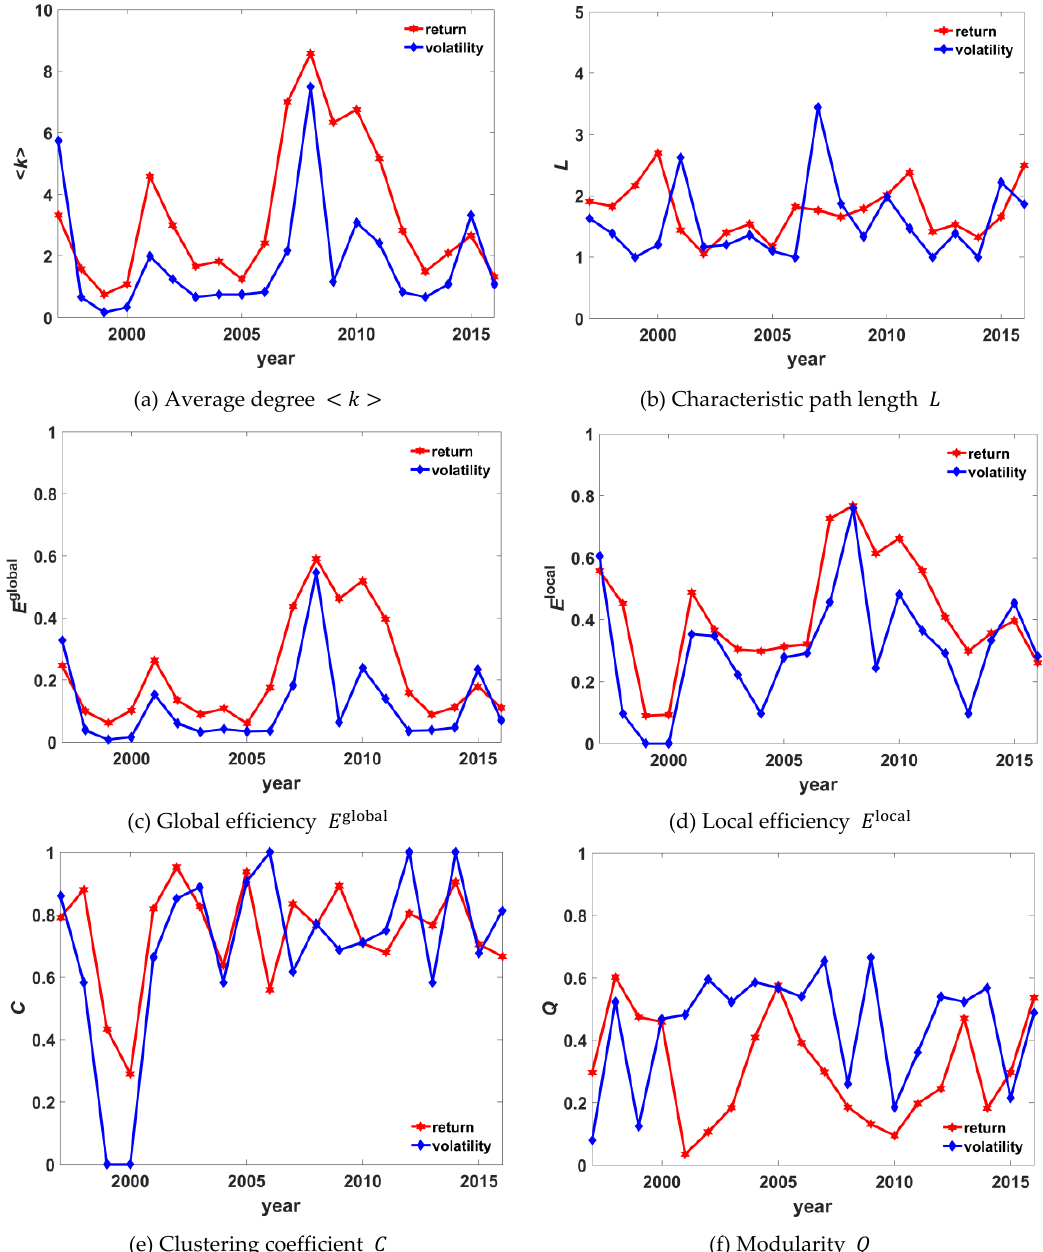
Figure 8. Network properties of return and volatility for global 24 stock markets of 1997–2016. See Table A for detailed